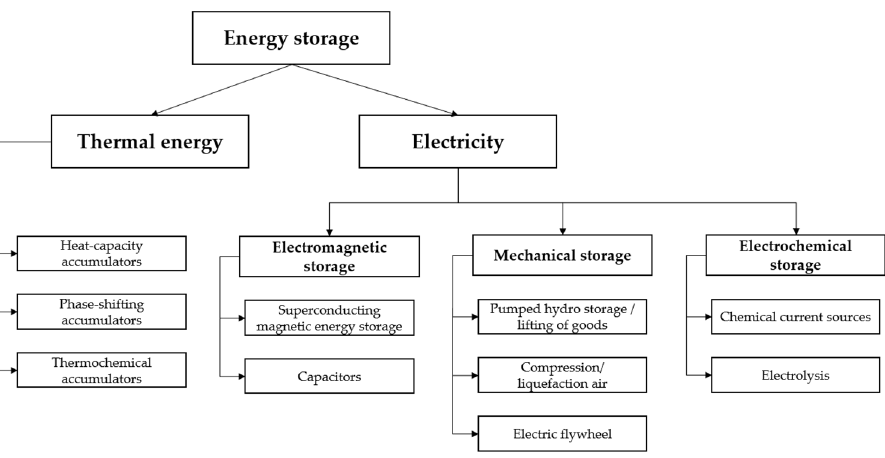
Figure 3. Classification of energy storage systems.